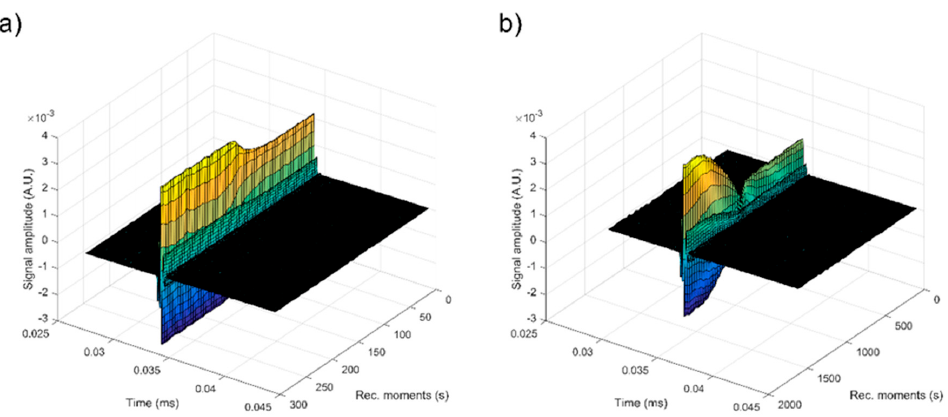
Figure 3. The same second echo selected for investigation for samples S1 ( a ) and S2 ( b ).